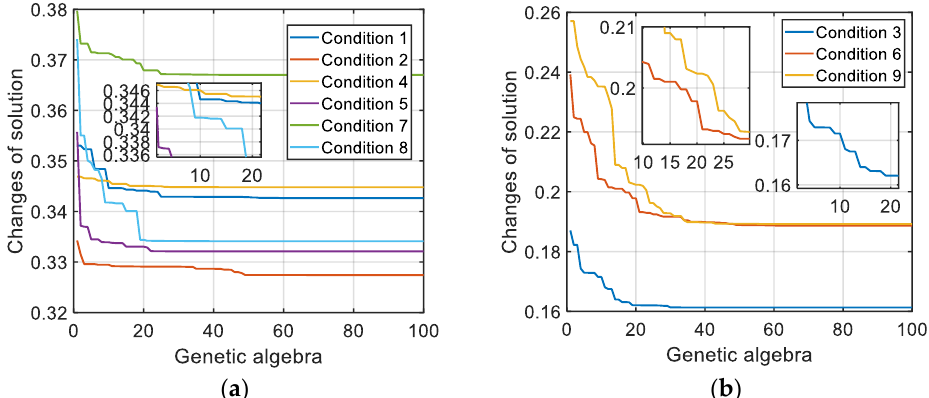
Figure 10. Iterative evolution curves of the I-GA (Method 1): ( a ) Medium and high-load working condition; ( b ) small-load working condition.